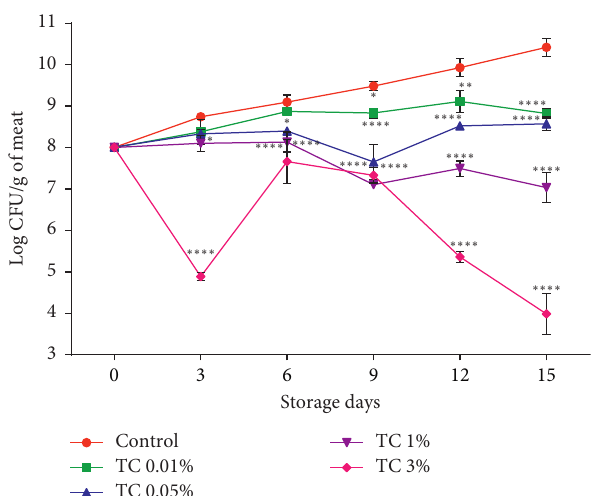
Figure 1: Time-related survival, at 4 ° C, of the high meat con- tamination level (10 8 CFU/g) of P. aeruginosa , following treatment with increasing concentrations of T. capitatus EO. The results represent the means of three replicate experiments, and error bars represent the standard error of the mean. Statistical significance differences: ∗ p < 0 . 05 (significant), ∗∗ p < 0 . 01 (very significant), and ∗∗∗ p < 0 . 001 and ∗∗∗∗ p < 0 . 0001 (extremely significant). CFU: colony-forming unit; TC: Thymus capitatus .